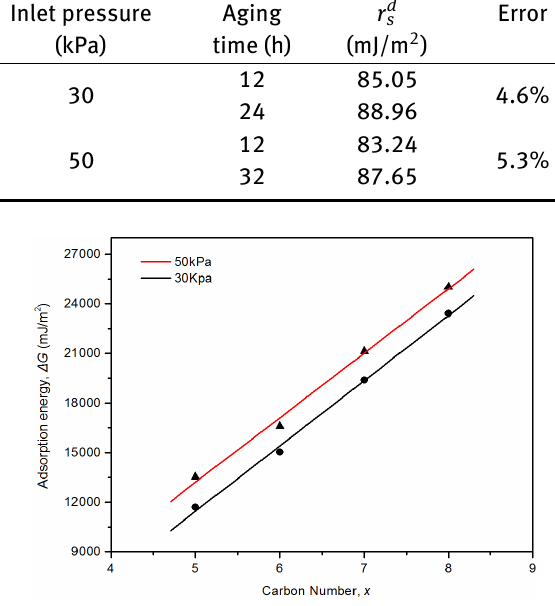
Table 2: r d s at different aging time of column (sample A)